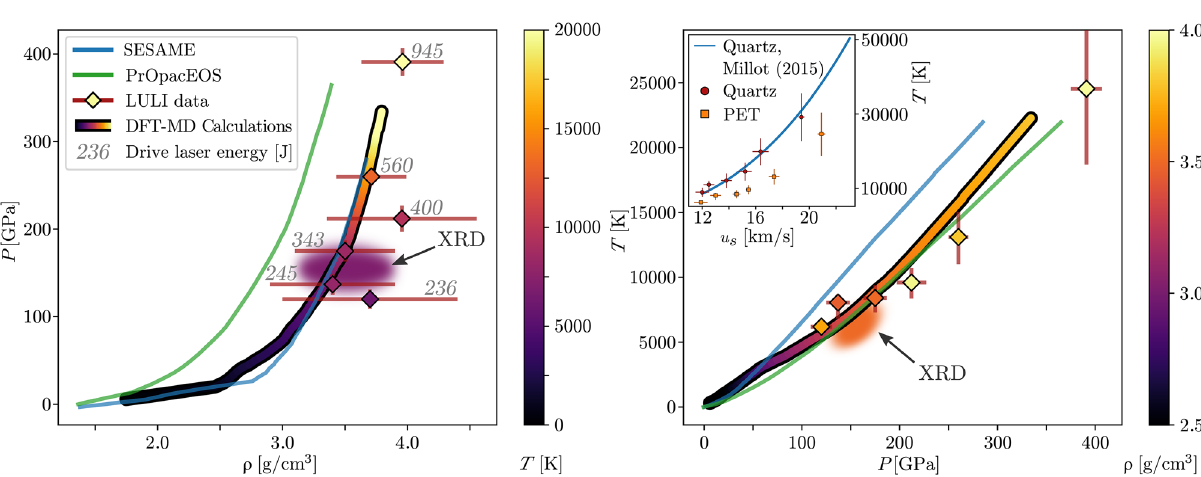
Figure 6. Hugoniot (left: pressure over density, right: temperature over pressure) of PET obtained from different equations of state (SESAME 07550 Mylar 12 , PrOpacEOS 4.0.0 C5H4O2 13 and ab initio DFT-MD simulations) and VISAR and SOP measurement at the LULI facility. For the latter two, the colour indicates temperature (left) or density (right). The blurred regions indicate T , P and ρ favoured by the comparison of artificial XRD images with the experiment. Numbers next to the data-points denote the energy of the laser drive. XRD, DFT-MD and LULI data seem consistent within the error margins, whereas SESAME and PrOpacEOS disagree on temperature or pressure, respectively. Right insert: Temperature vs shock velocity relation in the quartz (circles) and PET region (squares) of the samples. The blue line indicates the dependency Millot at al. obtained for quartz 27